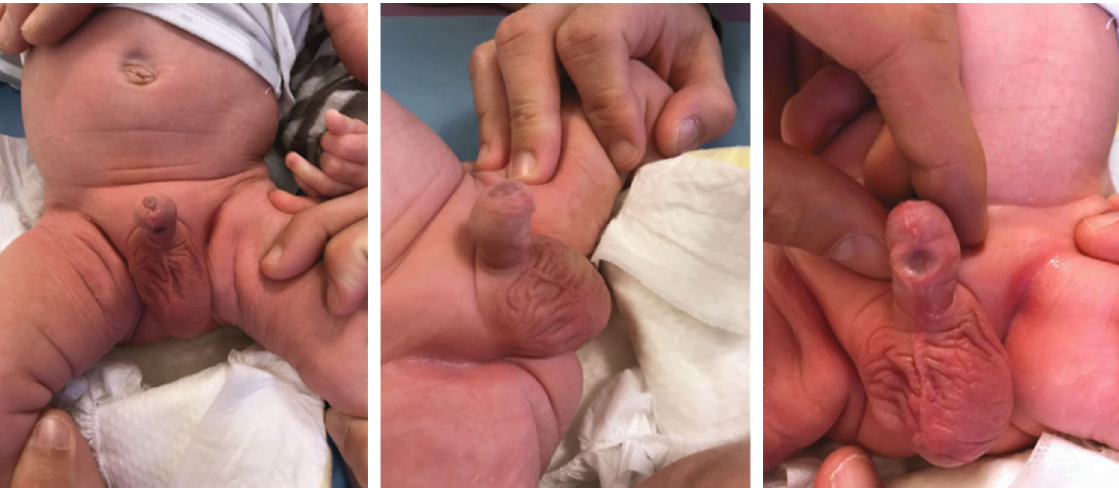
Figure 1: Clinical examination at the age of 1 month: an undamaged urethral wall with large corpus spongiosum and skin defect on the ventral aspect of the penis shaft. Associated right cryptorchidism.